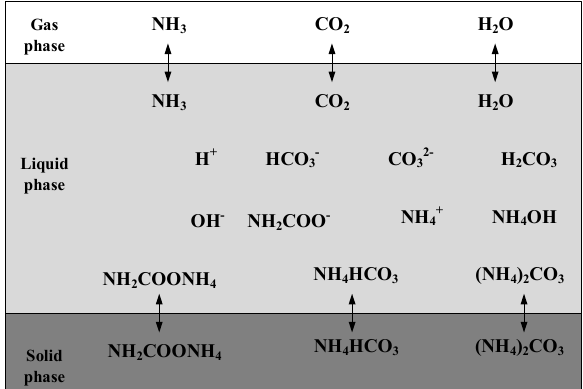
Figure 1. Chemical species and vapor − liquid − solid equilibrium phase for the NH 3 − CO 2 − H 2 O system [29].